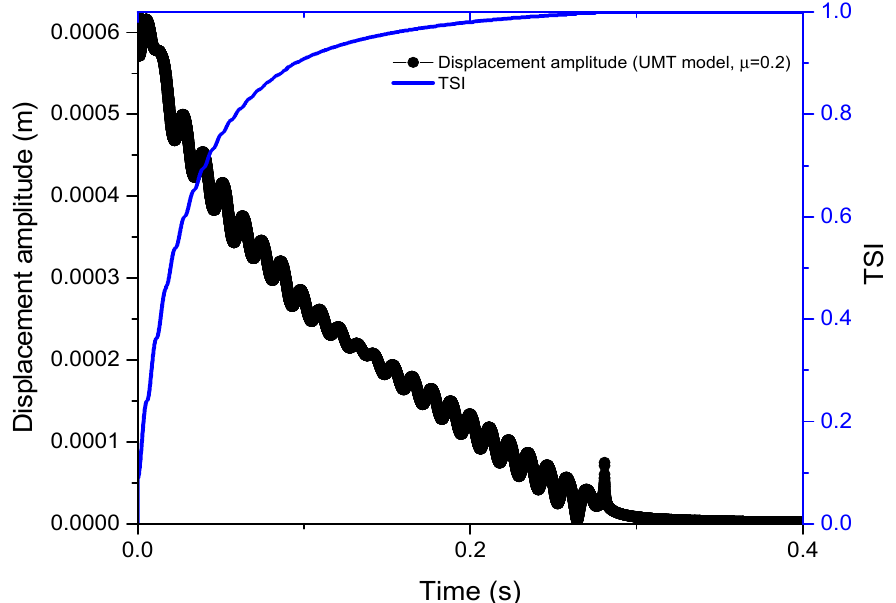
Figure 6. Change in the amplitude of oscillation and evolution of TSI with time for frictional dissi- pation.